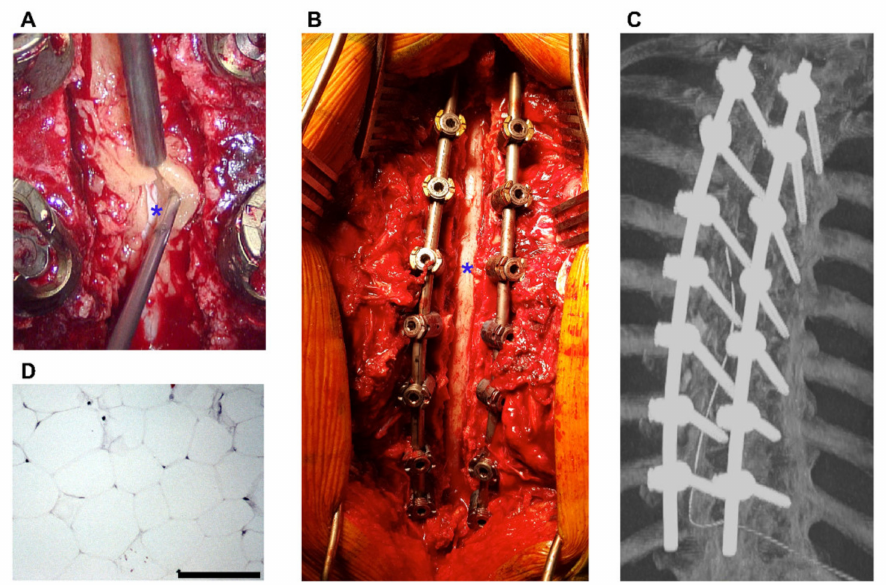
Figure 4. Intraoperative and postoperative images. ( A ) Intraoperative view of the microsurgical tumor removal. A section of SEL (yellowish mass) is lifted with an aspirator and a microsurgical punch from dura (marked with *). ( B ) Overview of the operation field at the end of tumor removal and spinal fixation, illustrating the extensions of the procedure. ( C ) Maximum intensity projection image of the postoperative CT scan. ( D ) H and E stained tumor slice after histopathological preparation, allowing the diagnosis of SEL with benign hypertrophic, unencapsulated fat cells (Bar represents 100 µ